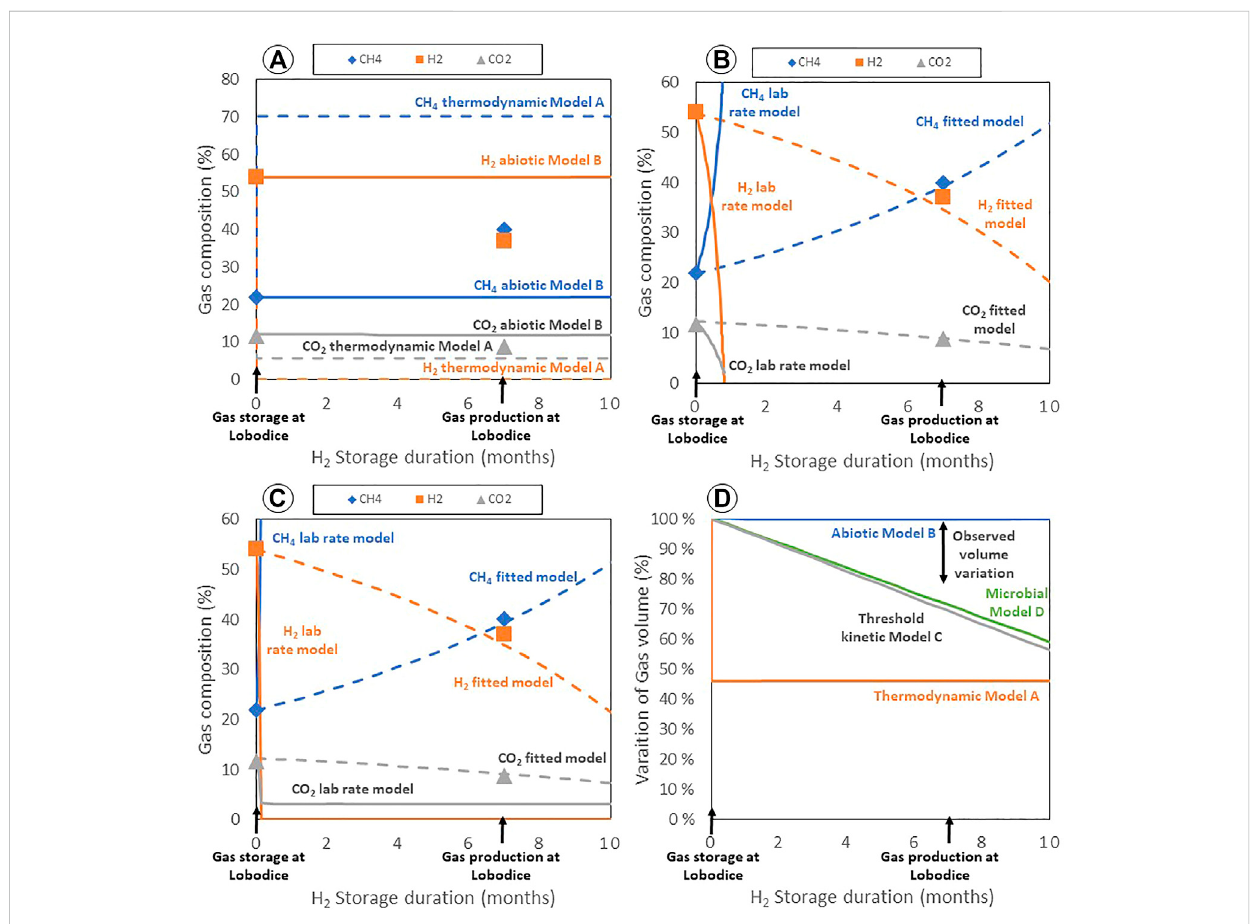
FIGURE 1 Gas composition evolution (A – C) and variation of gas volume (D) simulated and observed at Lobodice gas storage. Simulations made using the reactivity model for hydrogen assuming: (A) thermodynamic equilibrium for redox reactions (Model A), and assuming abiotic conditions (Model B); (B) a 0-order kinetic rate model with thermodynamic threshold limits (Model C); and (C) considering a kinetic model depending on substrate concentrations and thermodynamic energy yield and concentration of bacteria (Model